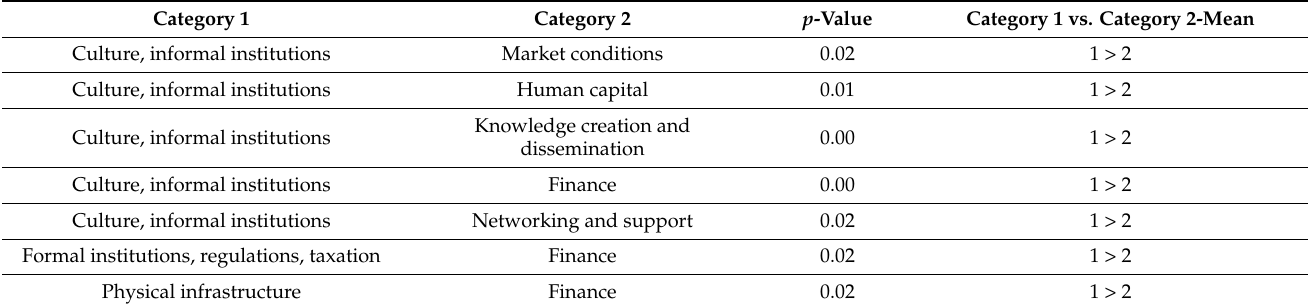
Table 2. Results of post hoc test, showing which category is more developed.